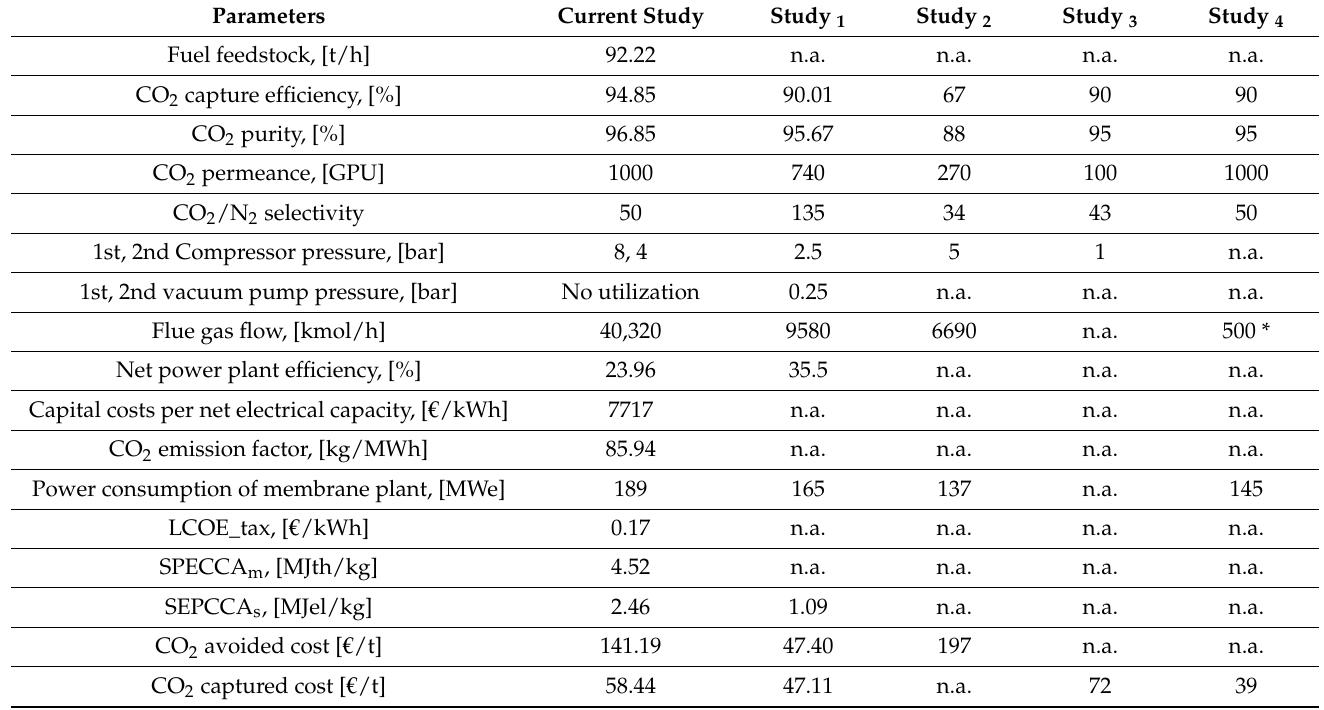
Table 19. The comparison of the current paper and different papers regarding technical and economical